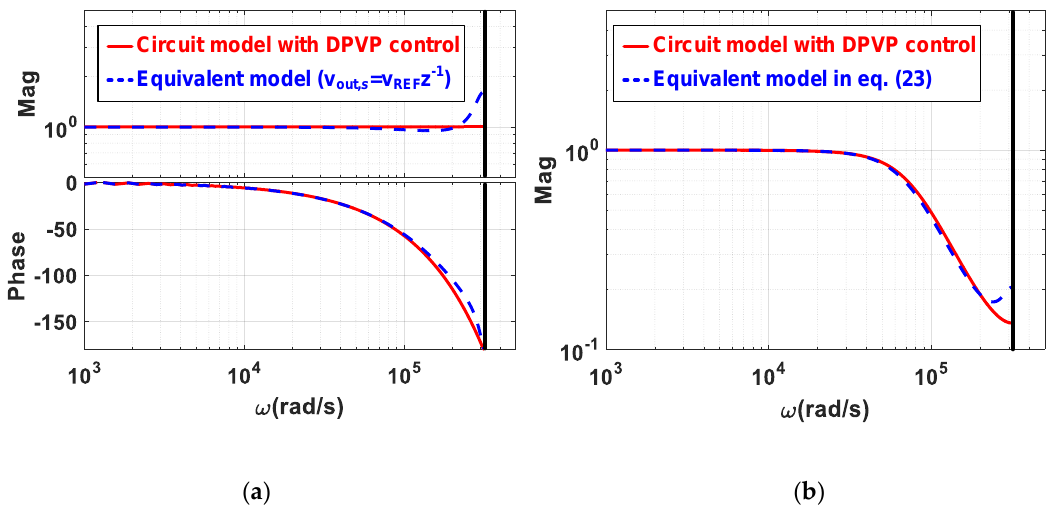
Figure 14. Frequency responses of the circuit model and the equivalent model: ( a ) Open-loop analysis for the v REF − > v out, s transient without integral compensation and ( b ) closed-loop analysis for the v REF − > v out, s transient with integral compensation.